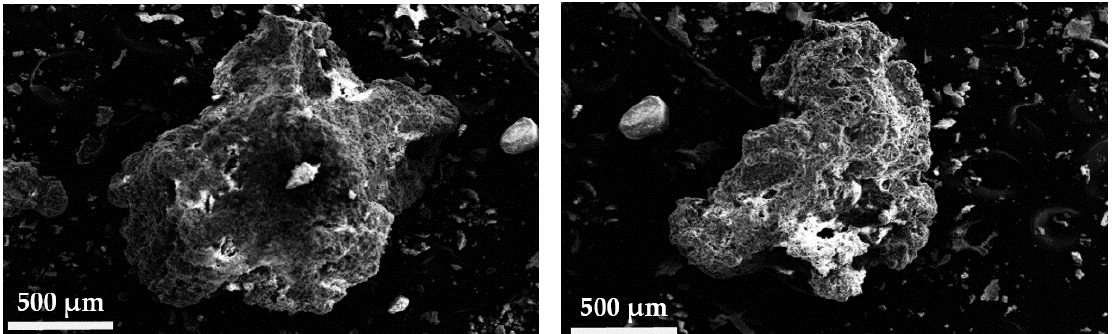
Figure 8. Microphotographs of the asphalt fraction associated with metals.